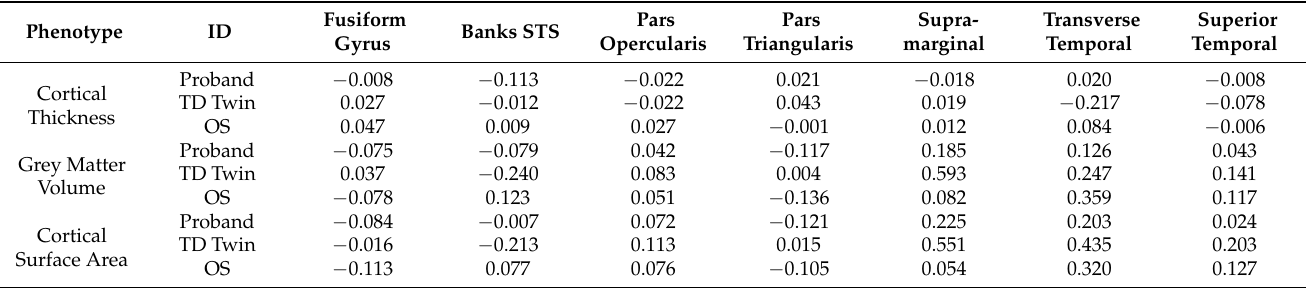
Table 3. Asymmetry values of cortical thickness, cortical surface area, and grey matter volume in reading-related ROIs. Positive values indicate leftward asymmetry and negative values indicate rightward